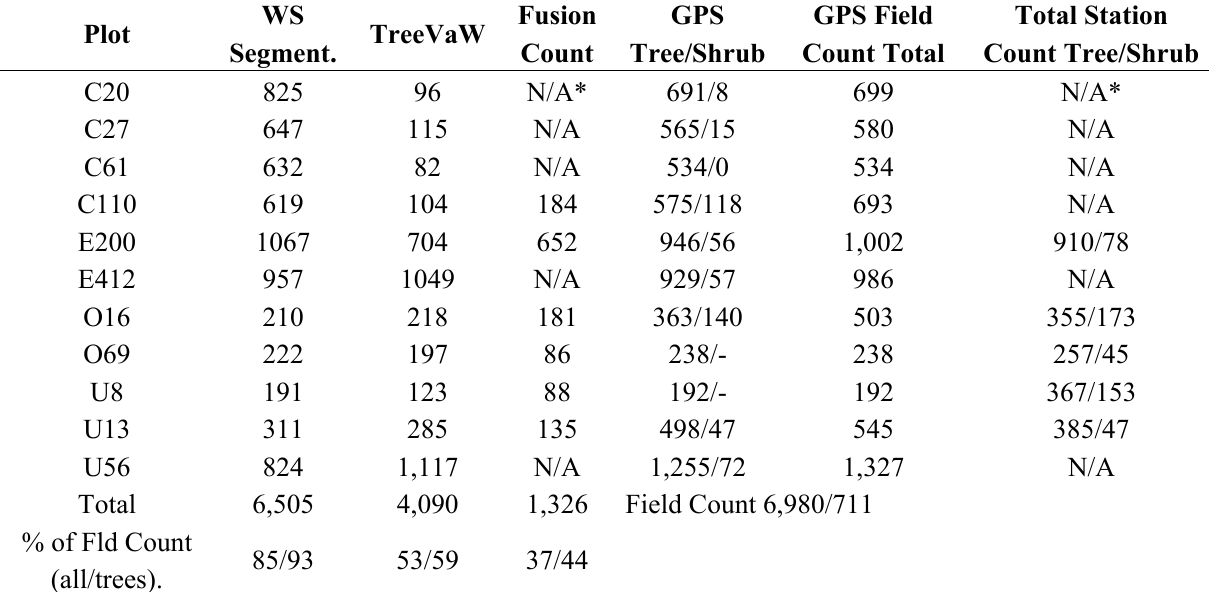
Table 7. Tree feature count by LiDAR extraction method compared to field count by total station and